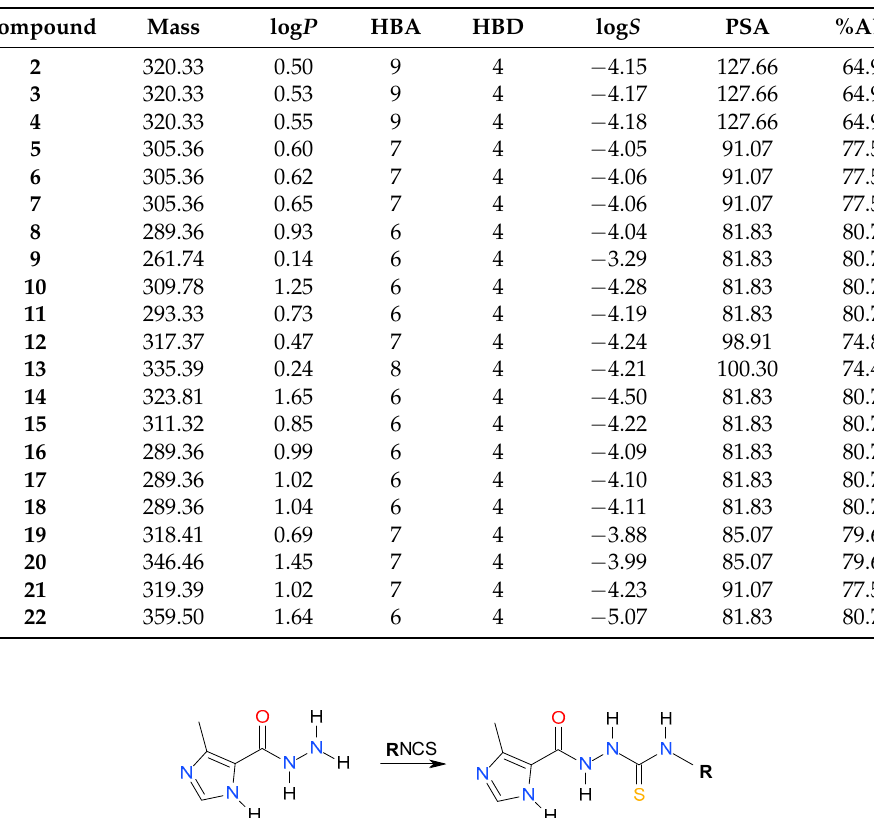
Table 1. Physicochemical properties of 2 – 22 important for CNS penetration. HBA—number of hydrogen bond acceptors; HBD—number of hydrogen bond donors; log S —solubility; PSA—polar surface area in Å; %ABS—percentage of absorption.